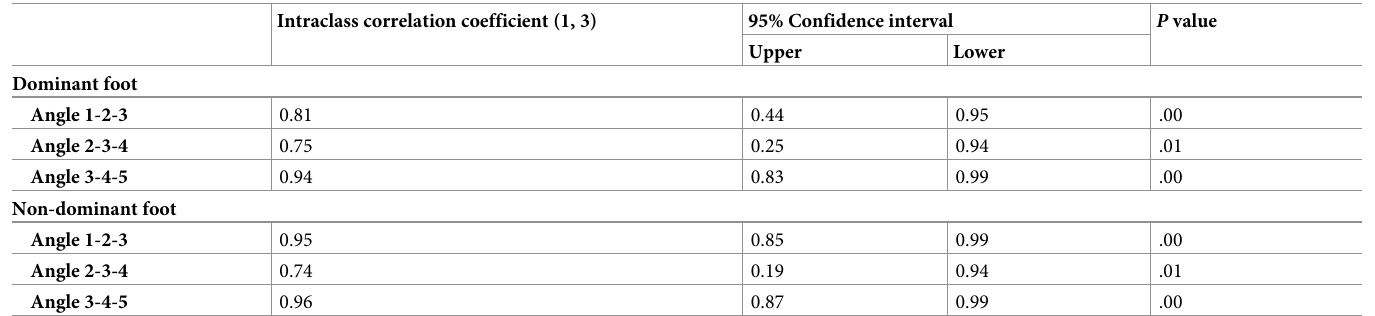
Table 2. Interclass correlation coefficient for measuring metatarsal alignment.